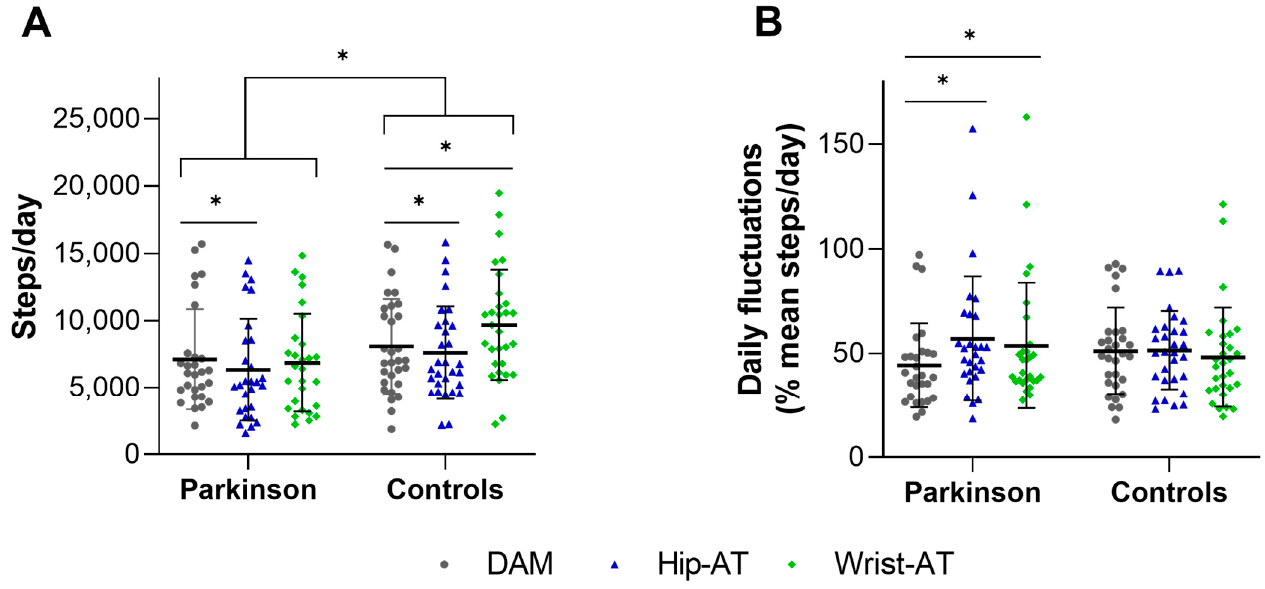
Figure 2. Differences between DAM and both ATs in PwPD and HCs for steps/day (panel (A)) and daily fluctuations (panel (B)). Each individual participant’s mean steps/day (panel ( A )) and mean daily fluctuation (panel ( B )) is represented with a point, for the DAM (grey dots), Hip-AT (blue triangles), and Wrist-AT (green diamonds). Thick horizontal lines mark the group’s mean and the whiskers show the SD. * Indicates significant differences. Hip-AT = Fitbit Zip or Fitbit Inspire; Wrist-AT = Fitbit Alta or Fitbit Inspire; DAM = Dynaport Movemonitor.